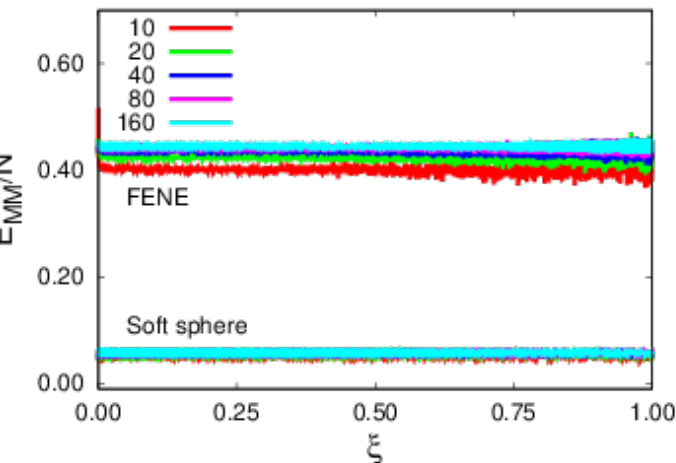
Figure 5. Plots of the monomer–substrate energy contribution per monomer as a function of rescaled time, ξ , for polymers of various sizes.